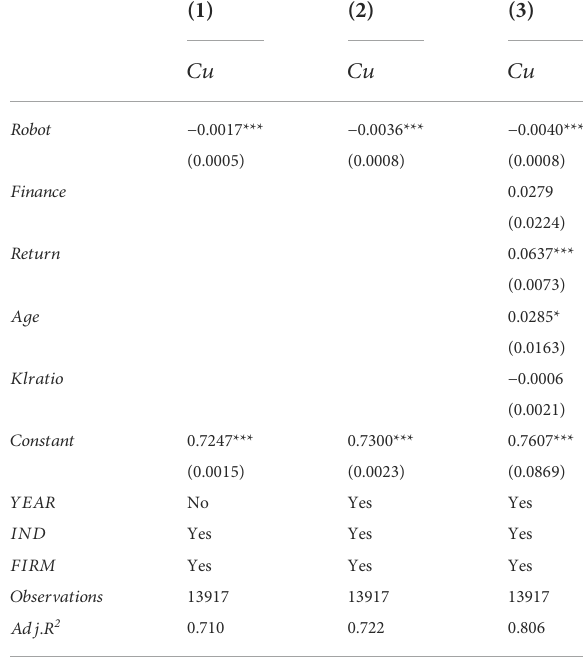
TABLE 3 Summary statistics.